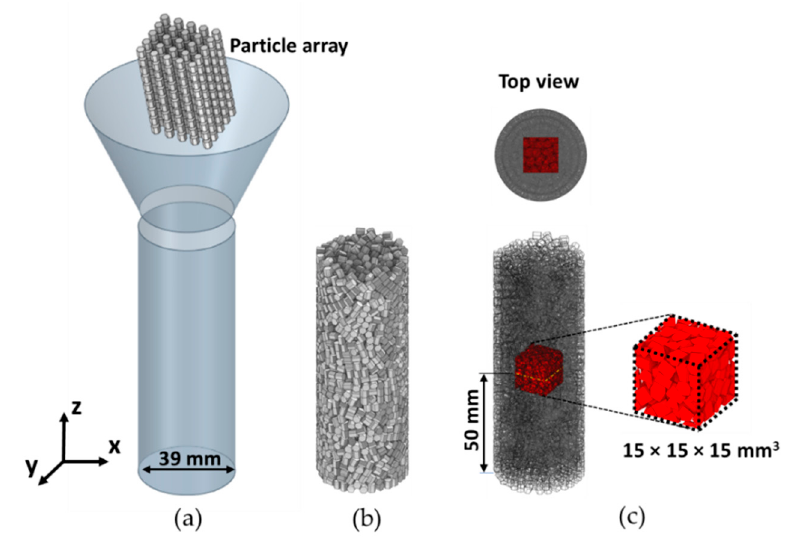
Figure 2. ( a ) Blender simulation of bed filling with particle array of 250 particles and ( b ) completely packed bed. ( c ) The smaller cubical domain highlighted in red was selected for thermal simulations, it is illustrated here with hexagonal prisms.